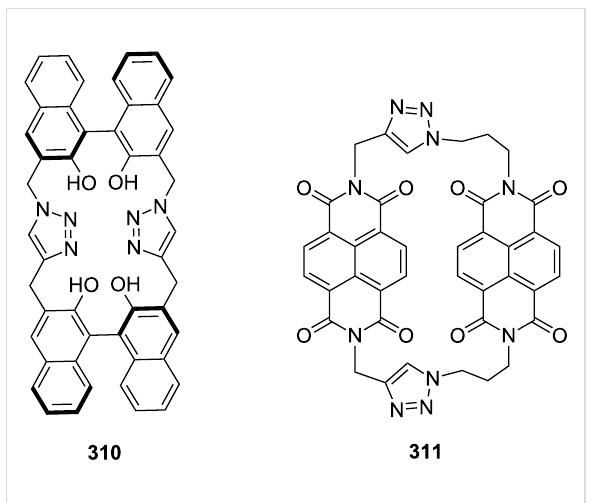
Figure 11: Cyclophanes 310 and 311 prepared via click